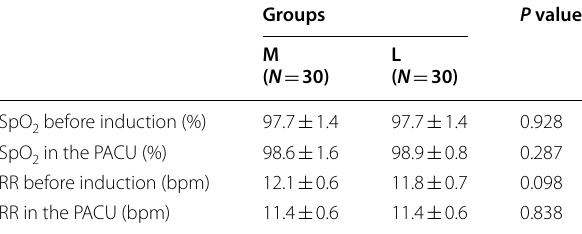
Data are presented as mean